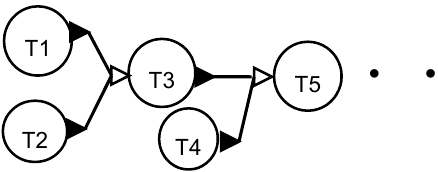
Figure 8. Front-end driven recipe patterns with multiple independent task.